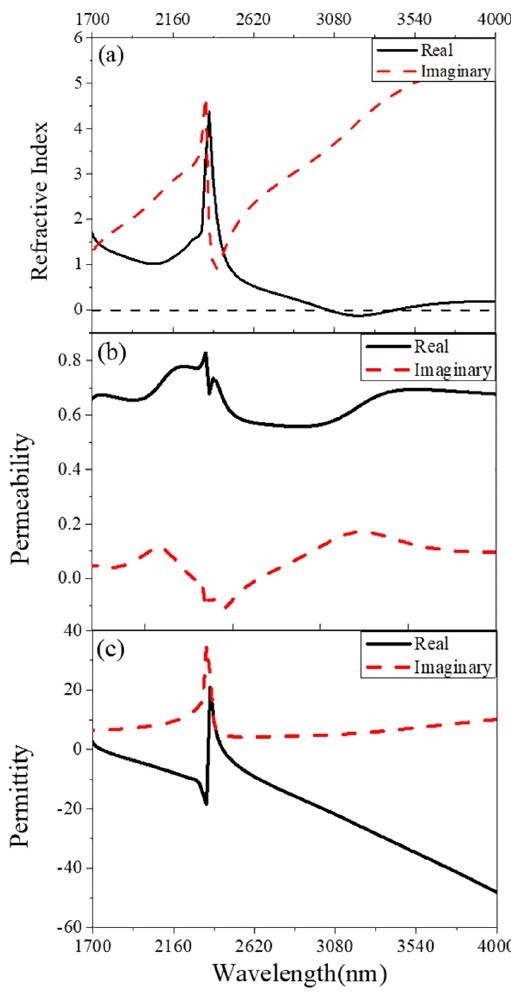
Figure 3. The simulated refractive index ( a ), the permeability ( b ) and the permittivity ( c ) of the fishnet MMs.